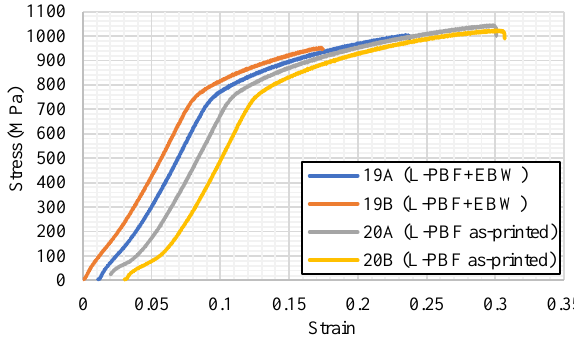
Figure 12: Typical stress- strain curves for EBW’ed samples 19A/B (180.4J/mm) and as-printed sample 20A/B. A slight horizontal shift (0.01 cumulative) of the data for samples 19A, 20A, and 20B was intentionally performed to avoid overlapping of the curves